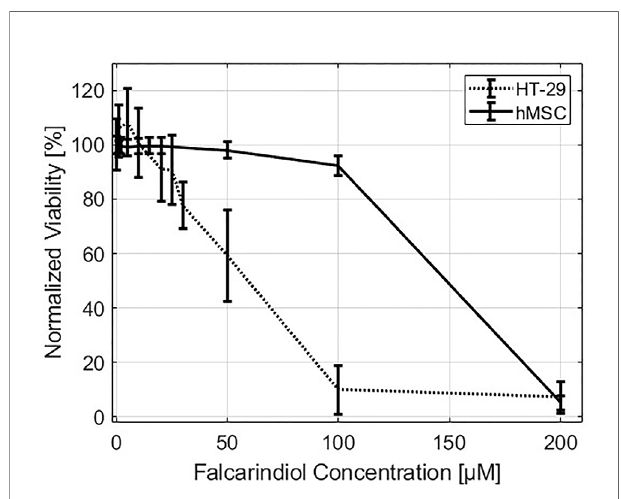
FIGURE 1 | Viability. Normalized viability of HT-29 (dotted line) and human mesenchymal stem cells (hMSCs) (solid line) as function offalcarindiol (FaDOH) concentration in the cell culture medium measured after three days of